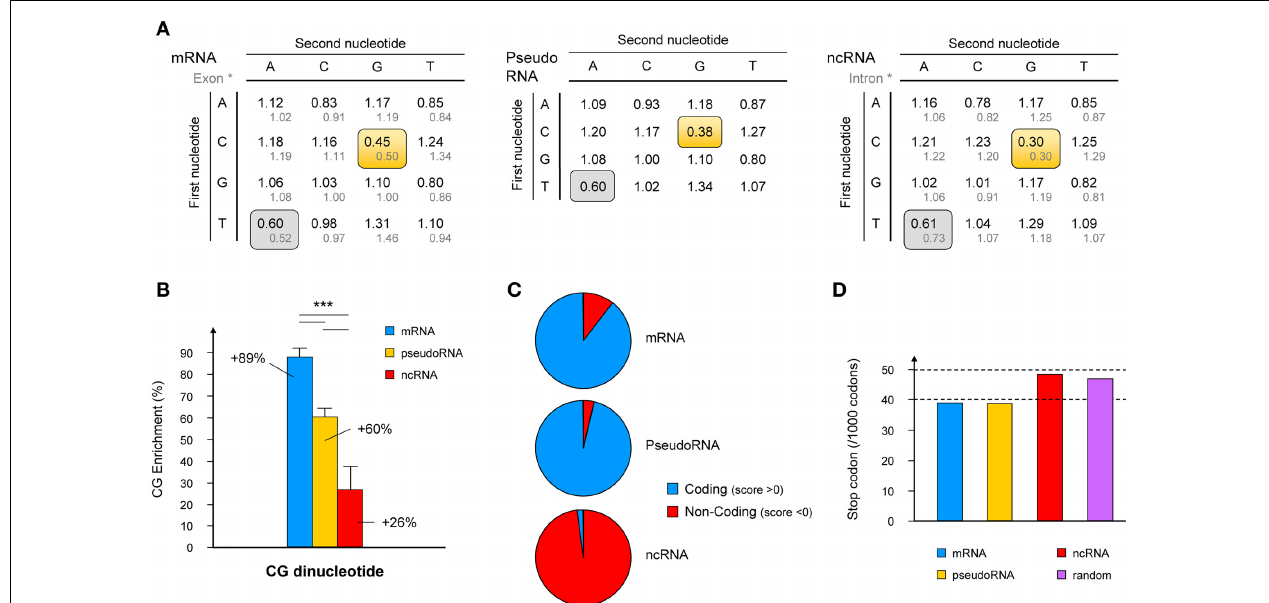
FIGURE 1 | Characterization of specific features of the “bona fide” lncRNA database. (A) Frequencies of occurrence of dinucleotides amongst the “bona fide” lncRNAs compared to that in mRNAs and pseudogenic RNAs (pseudoRNA) and compared to published dinucleotide frequencies in intronic and exonic sequences (Bulmer, 1987) (gray text). Frequencies of underrepresented dinucleotides are framed in gray where no difference is observed, or yellow where differences between mRNA, pseudoRNA and lncRNA are observed. (B) The CG dinucleotide signature for mRNAs, pseudoRNAs and lncRNAs is expressed as a% enrichment over the frequency of CG dinucleotide in the whole human genome. Histograms